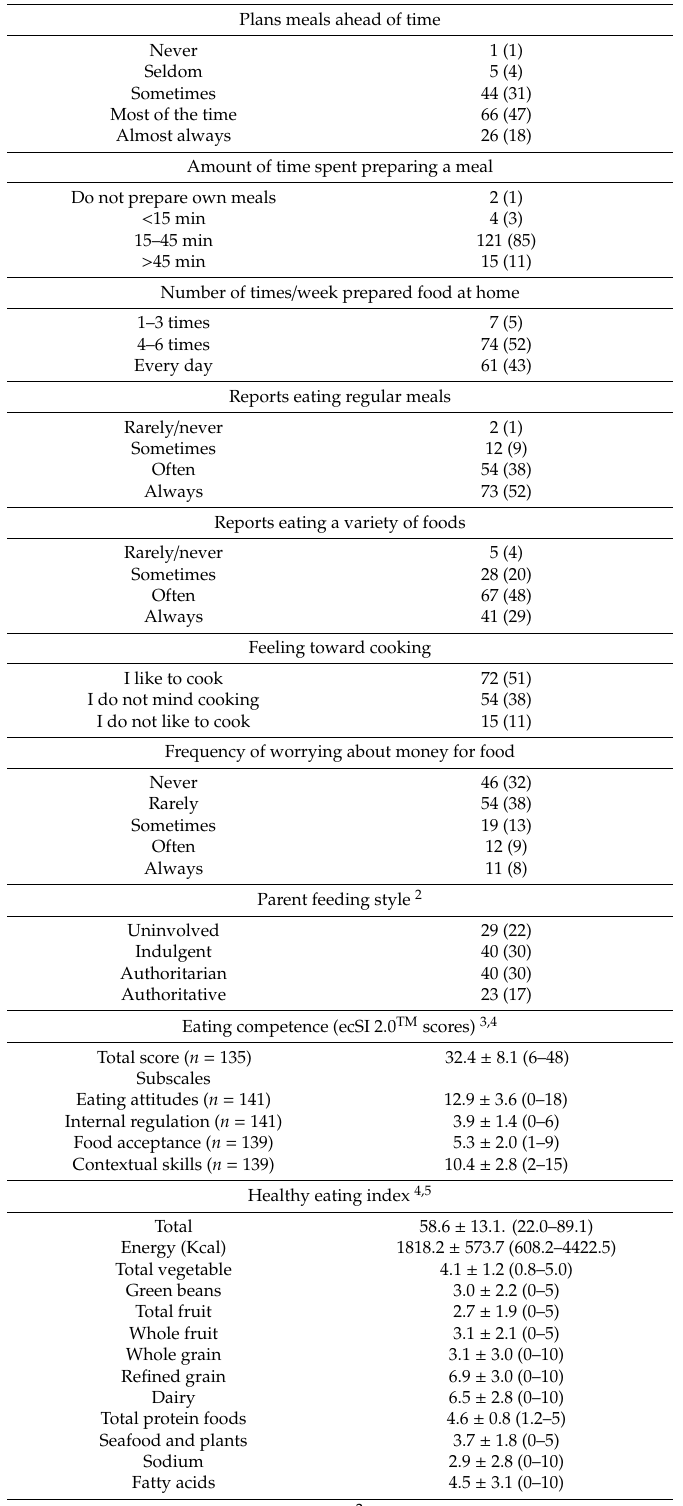
Table 2. Culinographic, eating behavior and dietary intake characteristics of parents of 4th grade youth participating in a dietary assessment component of a nutrition education intervention 1